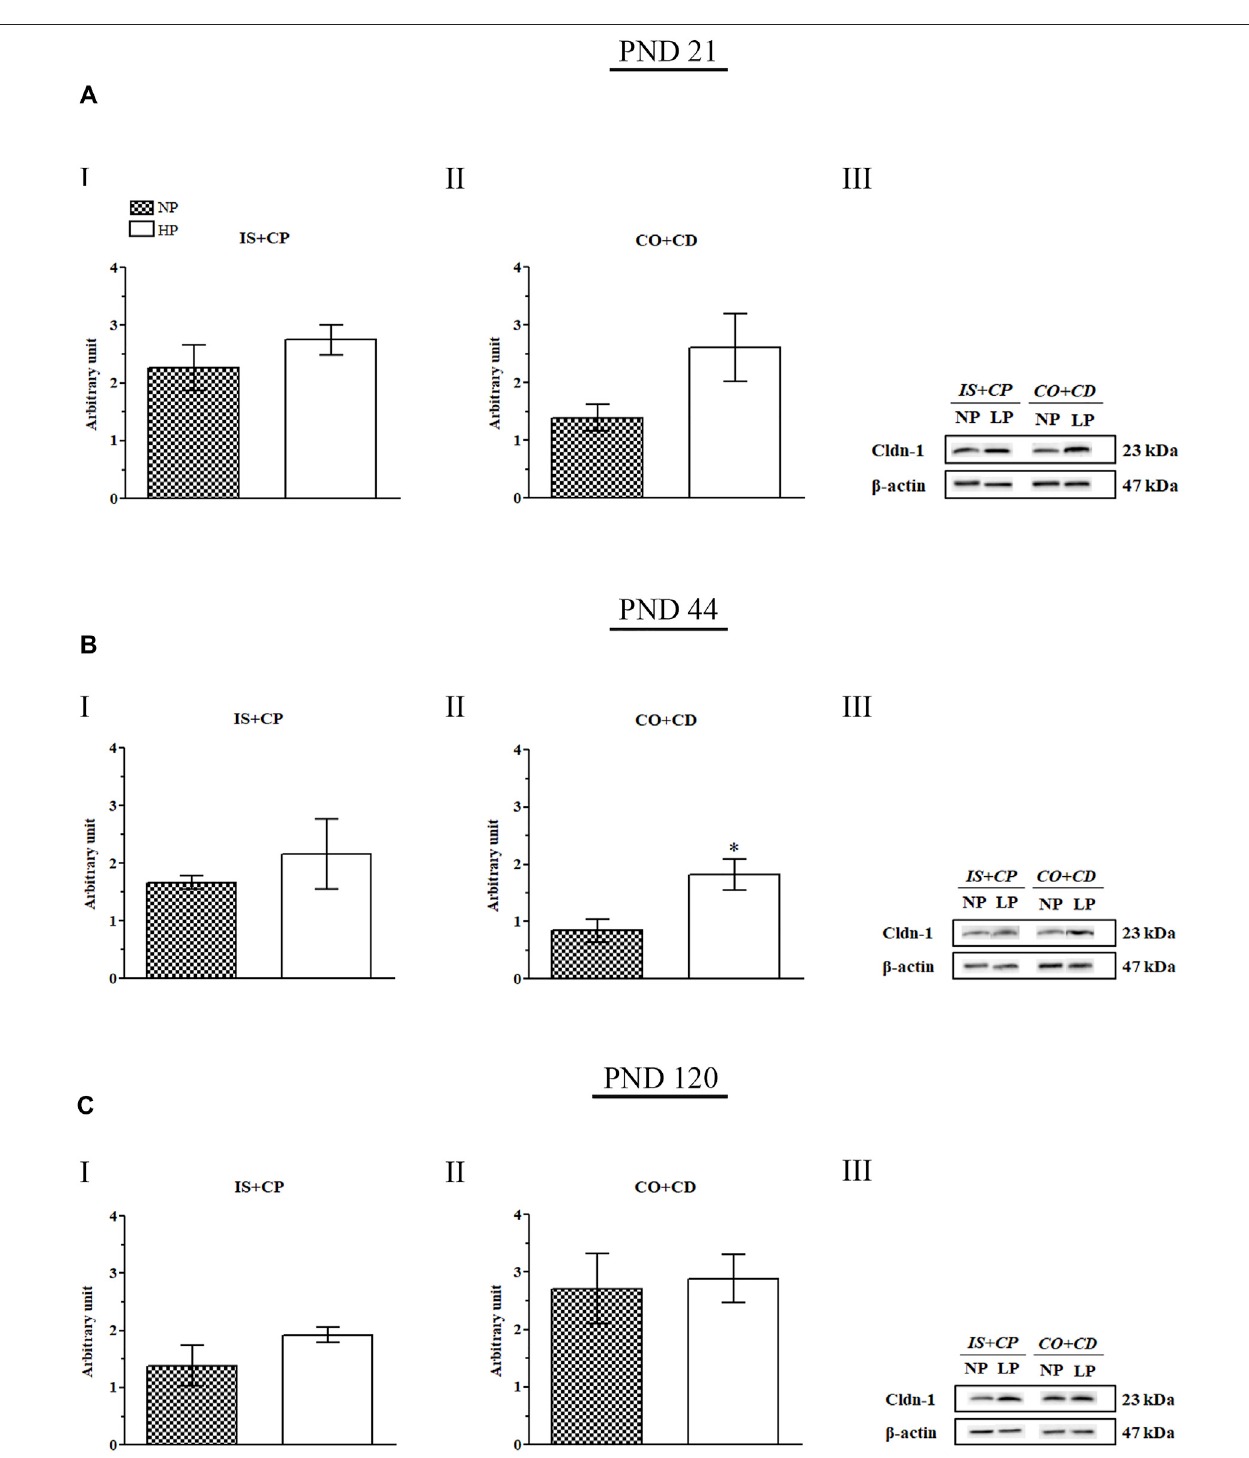
FIGURE 9 | Cldn-1 immunoblot. (A) Levels of Cldn-1 in the IS + CP (I) and CO + CD (II) epididymal regions of NP and LP animals on PND 21. The representative blotsshowtheproteinlevelsofCldn-1and β -actin(70 µgofprotein)in21-day-oldanimals (III) . (B) LevelsofCldn-1intheIS+CP (I) andCO+CD (II) epididymalregions ofNPandLPanimalsonPND44.TherepresentativeblotsshowtheproteinlevelsofCldn-1and β -actin(70 µgofprotein)in44-day-oldanimals (III) . (C) LevelsofCldn-1 in the IS + CP (I) and CO + CD (II) epididymal regions of NP and LP animals on PND 120. The representative blots show the protein levels of Cldn-1 and β -actin (70 µg of protein) in 120-day-old animals (III) . The data are presented as the mean ± S.E.M. * p < 0.05, Mann-Whitney test.